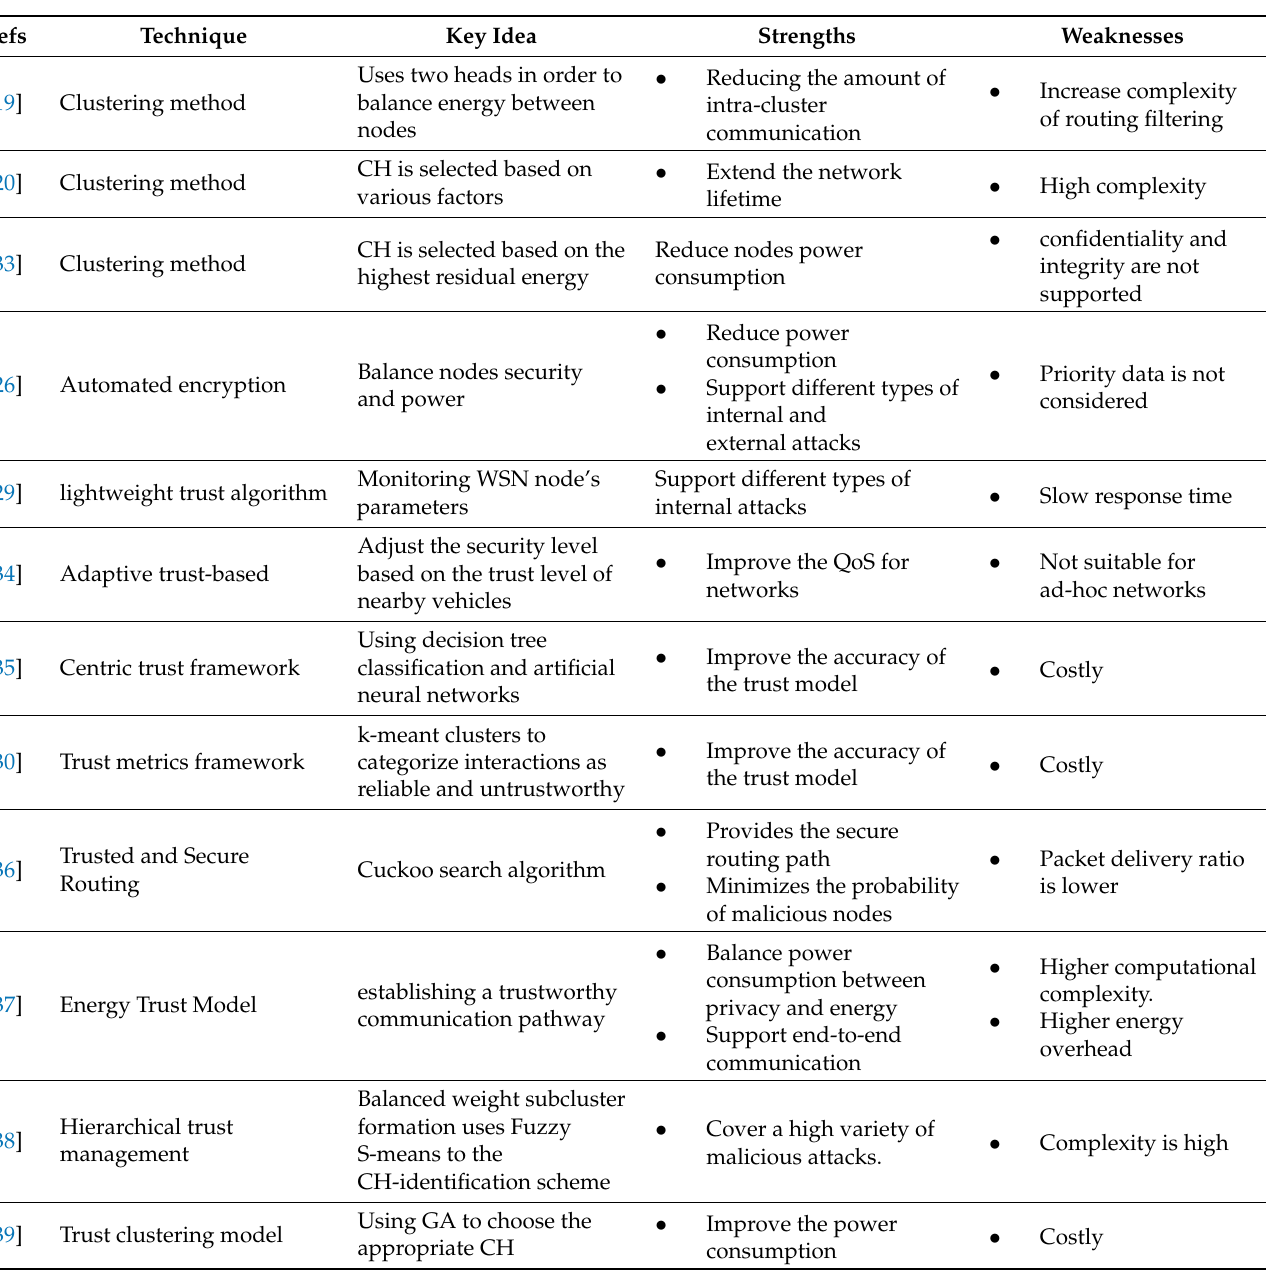
Table 1. Review of the trusted-based